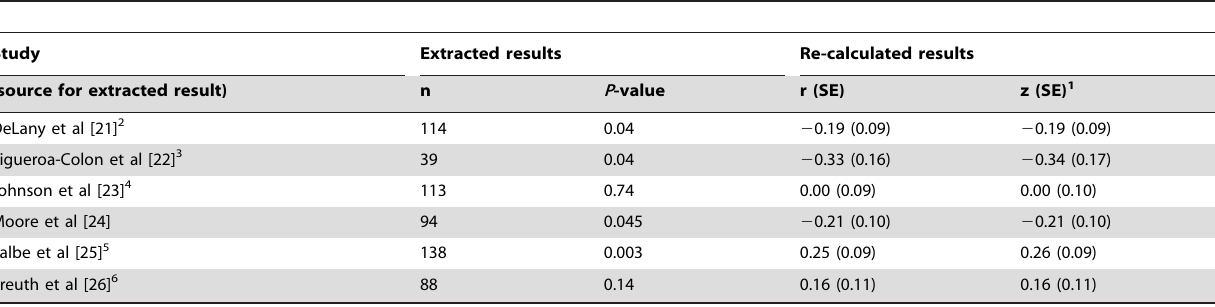
Table 2. Correlation coefficients of studies calculated from P -values according to the principal results extracted.